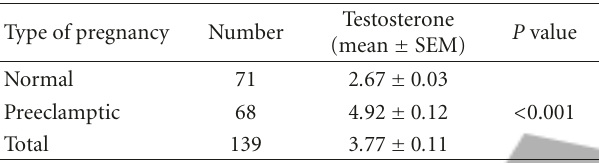
Table 5: Comparison of mean serum testosterone level between normal and preeclamptic